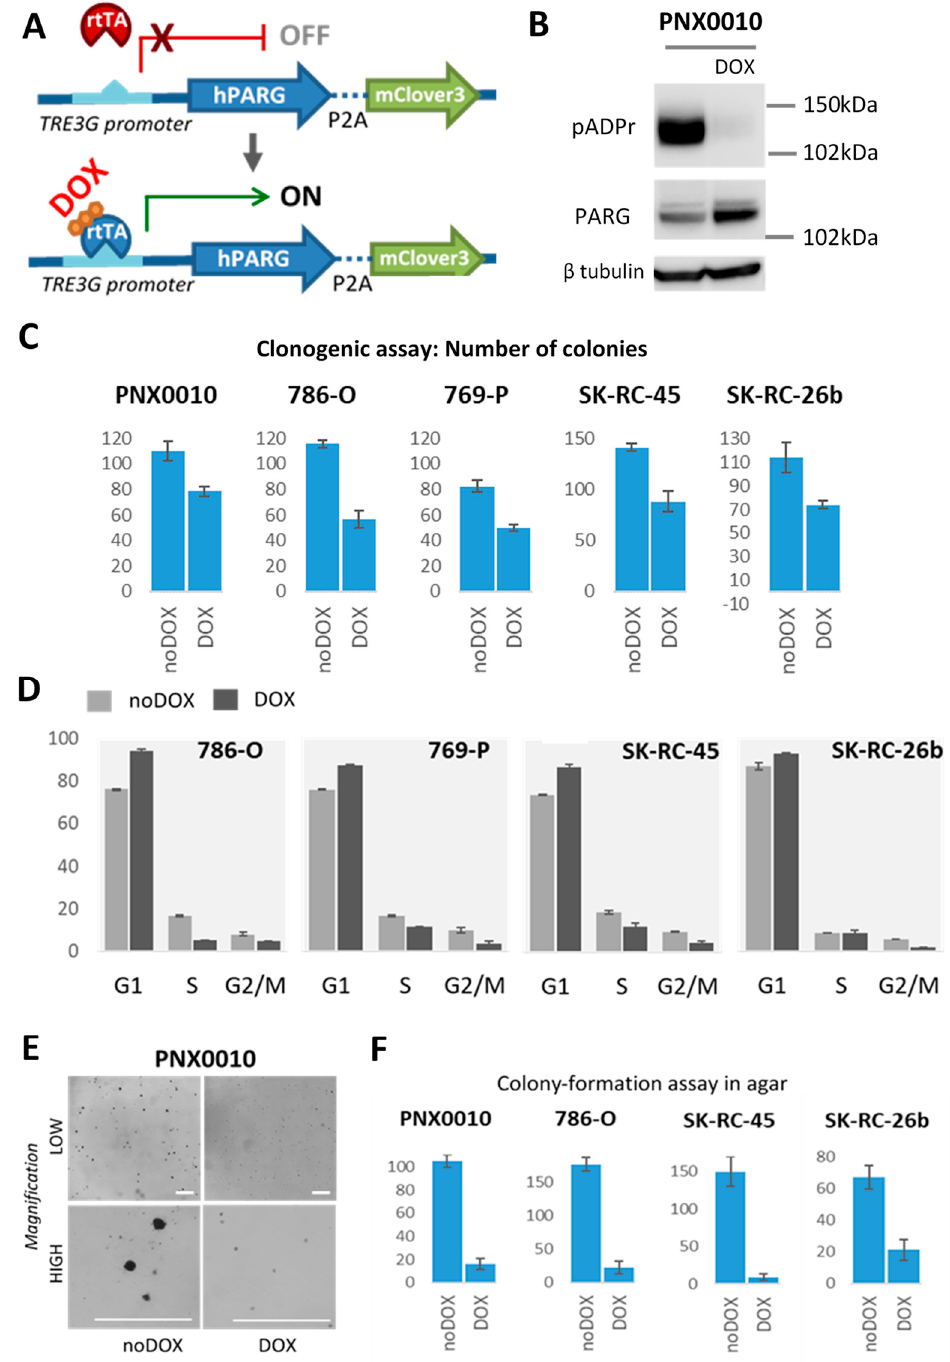
Figure 3. PARG overexpression reduces tumorigenicity of ccRCC cell lines. ( A ) Schematic repre- sentation of doxycycline inducible system for PARG overexpression experiment. HIS-tagged PARG cDNA was cloned into lentivirus plasmid pLVX-TetOne™-Puro (Takara) after doxycycline TET-On inducible promoter, followed by P2A cleavable mClover3 green fluorescence protein for expression visualization. Puromycin selection was utilized to expand positively transduced cells. ( B ) pADPr inhibition in PNX0010 cell lines overexpressing PARG under 500 ng/uL doxycycline stimulation for 72 h. Tubulin level is shown as a loading control. ( C ) cRCC cells were seeded at 500 cells per well at 6-well plate in triplicates and grown without/with 500 ng/mL doxycycline. Number of colonies were counted after 5–7 days of culture when the colonies reached the size around 50 cells/colony. ccRCC under PARG overexpression form less colonies when grown on plastic, p -value < 0.05. Sample wells